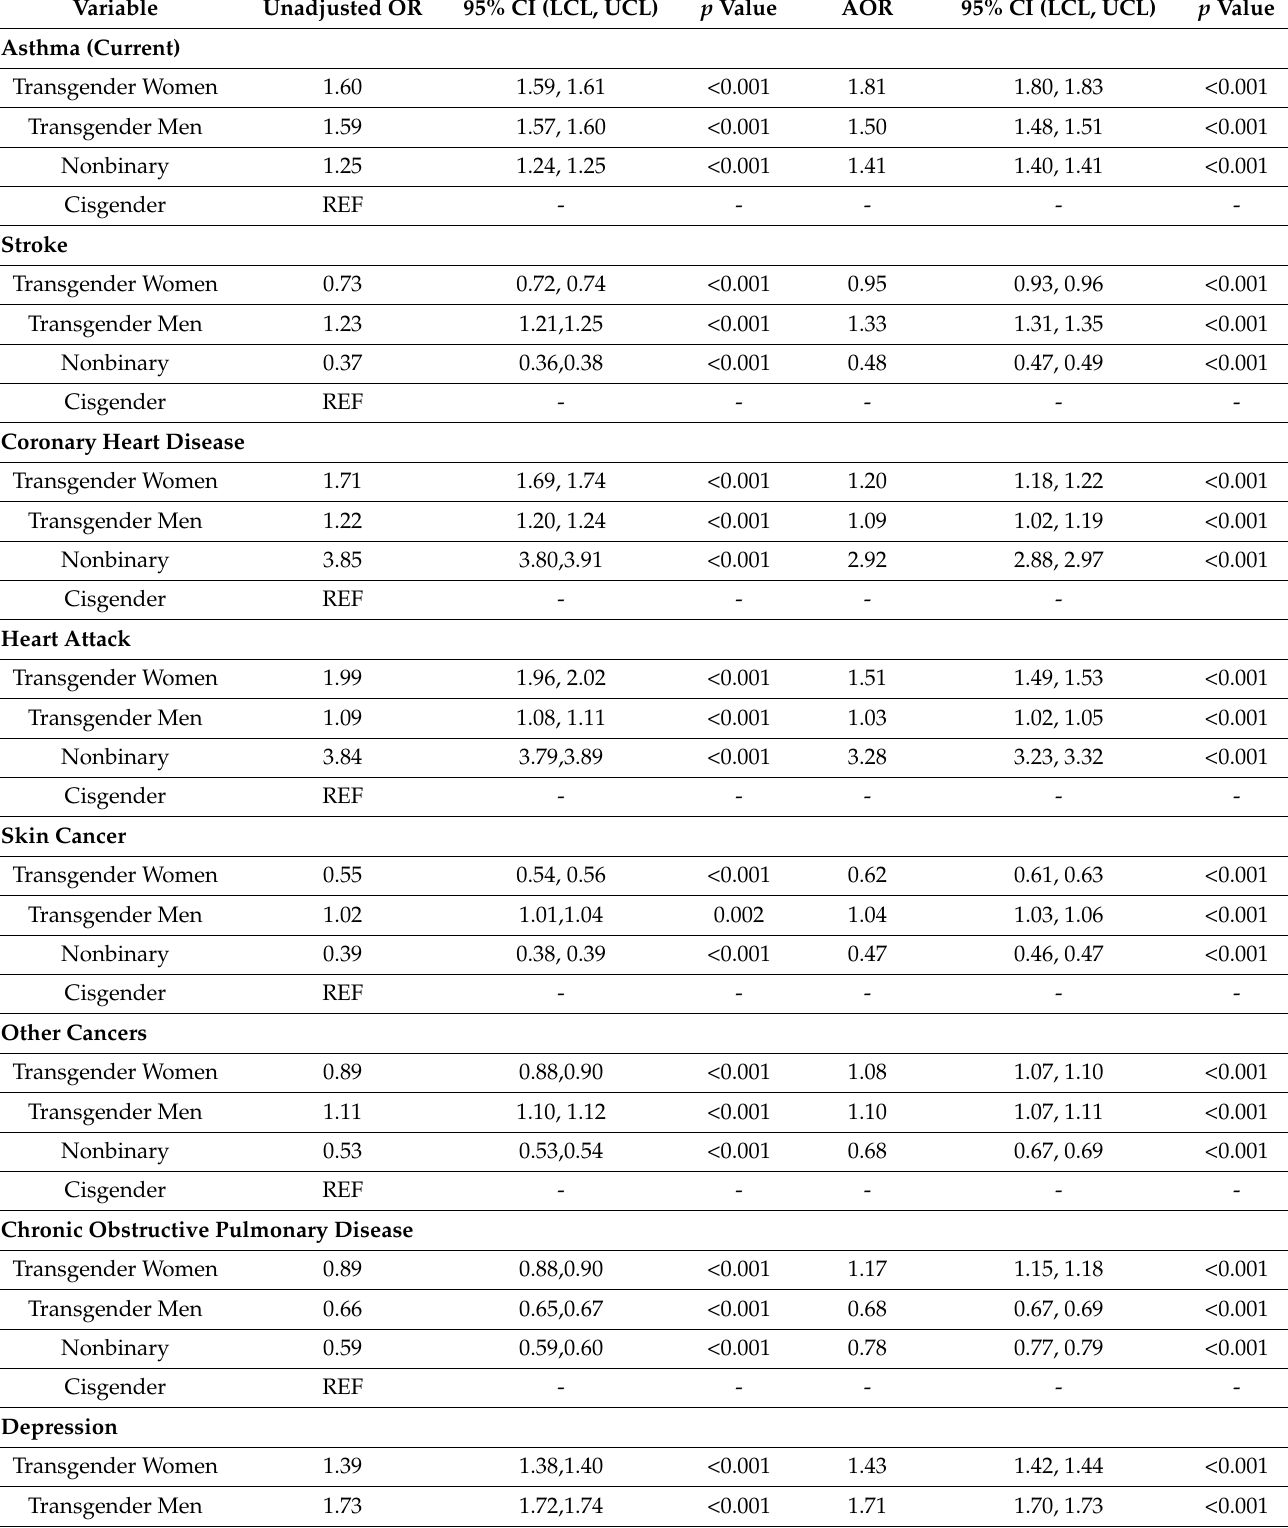
Table 6. Adjusted and unadjusted odds ratio for chronic health conditions among matched sample of un-pooled transgen- der